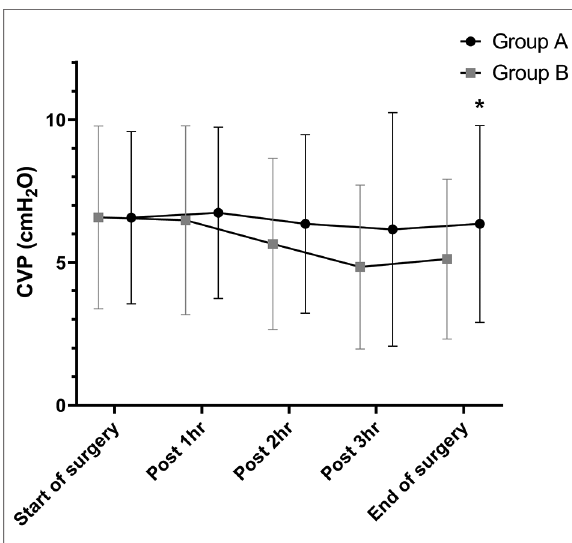
FIGURE 2 Differences in CVP during hepatic resection. CVPs showed a decreasing trend after the start of surgery until completion of hepatic parenchymal transection and then re-increased after fl uid challenge in both groups. There is a signi fi cant difference in CVP at the end of surgery between the two groups (6.35±3.45